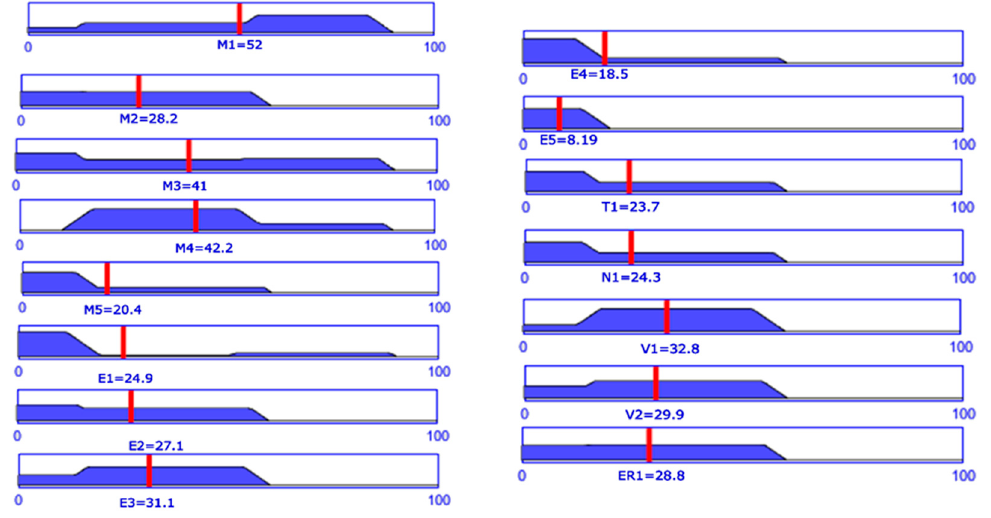
Figure 7. Risk level for each hazard computed using data from Table 7. Table 7. Data regarding the patients involved in the functional validation of the robotic system. Patient